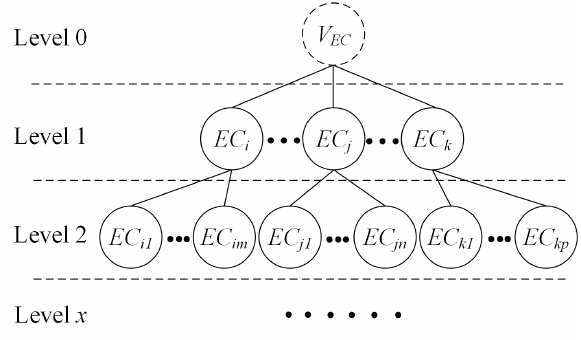
Figure 6. Structure of the entity class classification